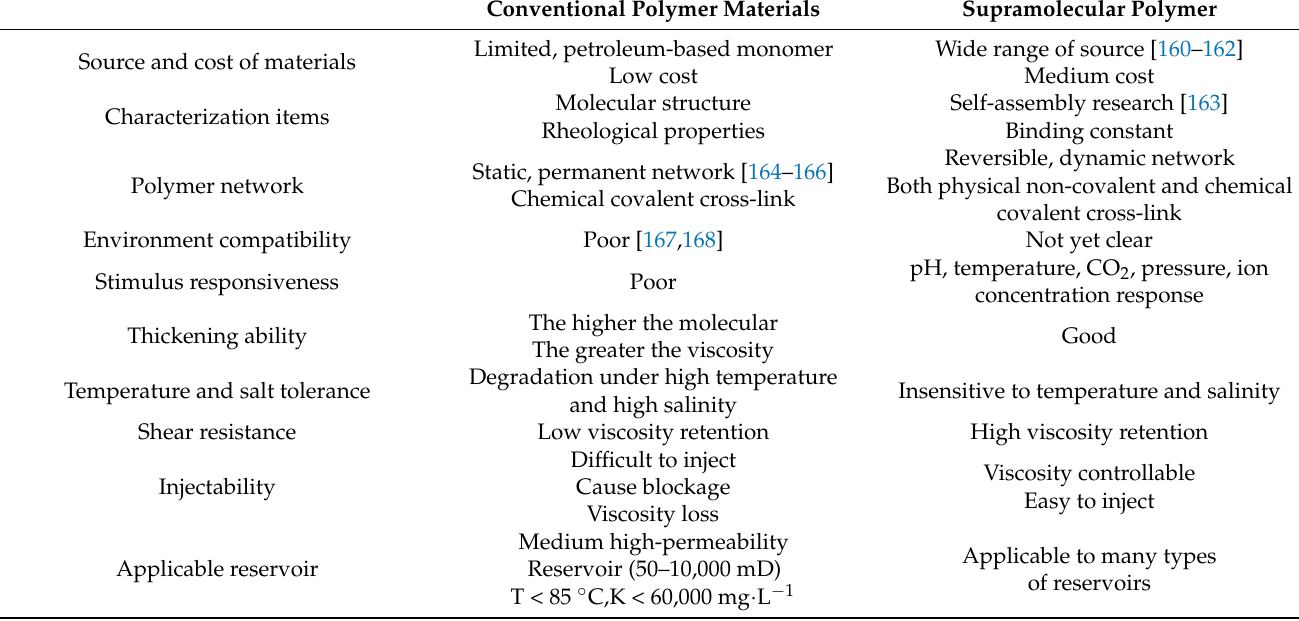
Table 1. Superiority of supramolecular polymers over conventional oil displacement polymers and the inevitable problems in their application in improving oil